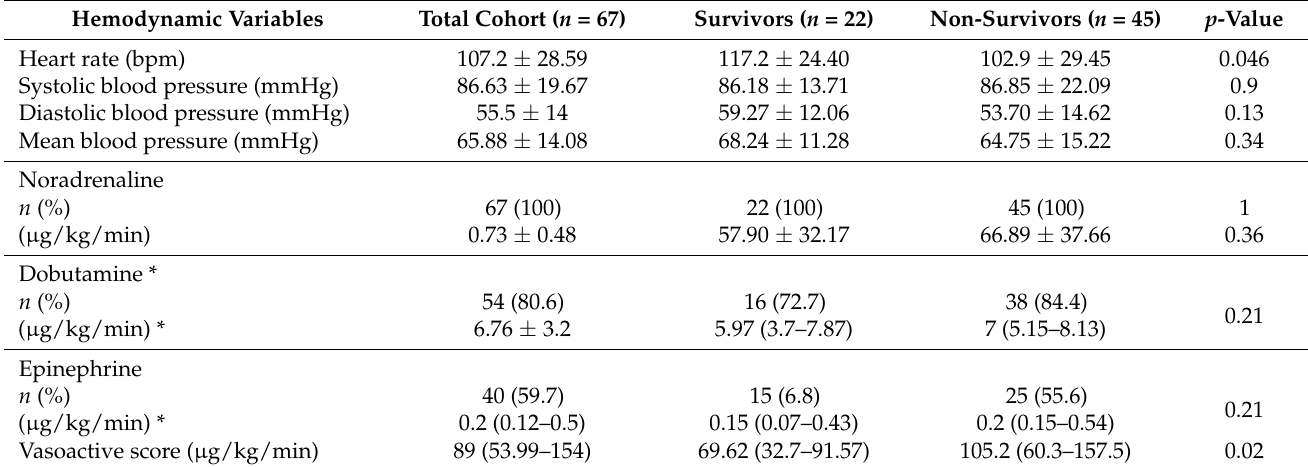
Figure 3. Serum lactate levels in all patients, survivors and non-survivors within 72 h after initiation of biventricular support. Table 2. Variables prior initiation of biventricular